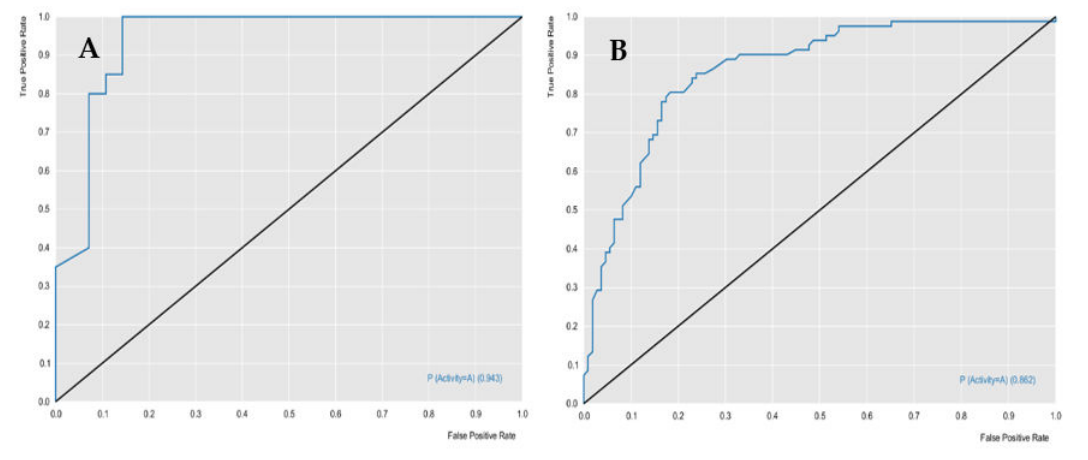
Figure 2. ROC curve generated for the L. braziliensis RF model. ( A ) Test and ( B )